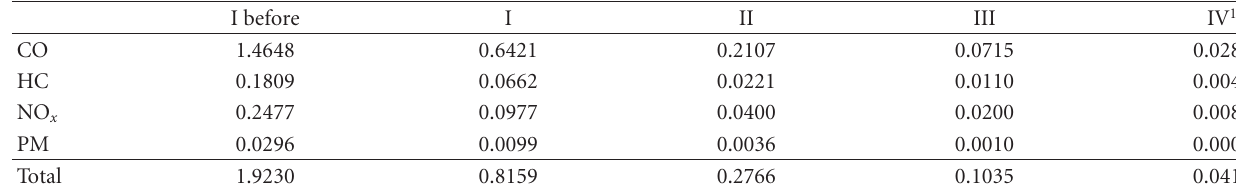
Table 5: Annual emissions of 4 pollutants for various standards.